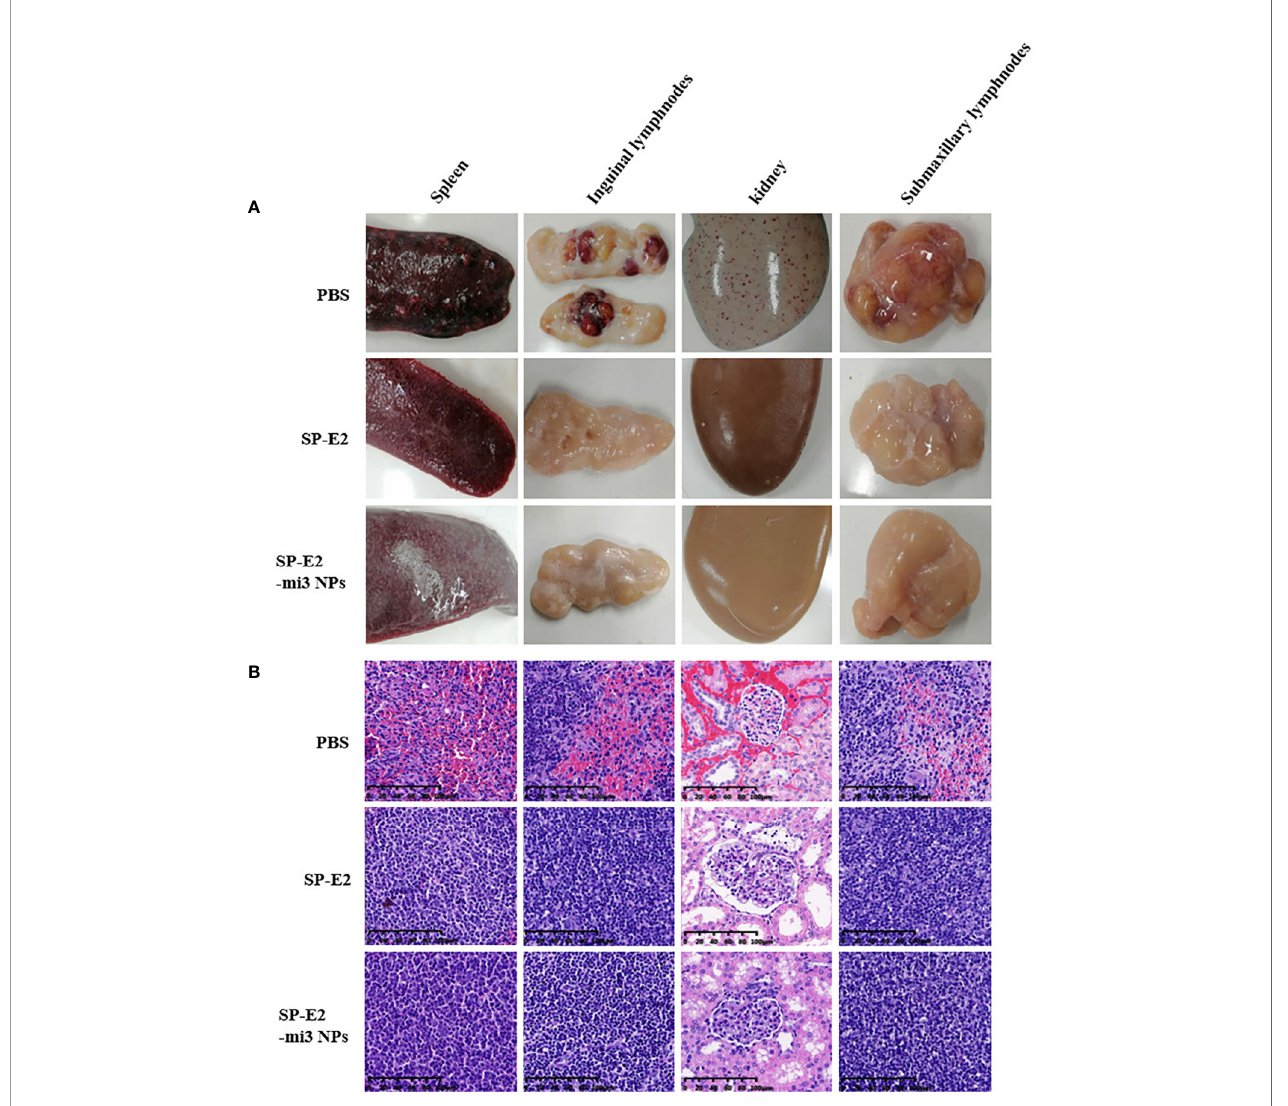
FIGURE 6 | Representative pathological and histopathological examination of vaccinated pigs upon CSFV lethal challenge. A variety of tissue samples, including inguinal lymph nodes, submandibular lymphatic nodes, kidney, and spleen, were collected and subject to pathological observation (A) and histopathological examination using hematoxylin – eosin staining (H&E) staining (B)